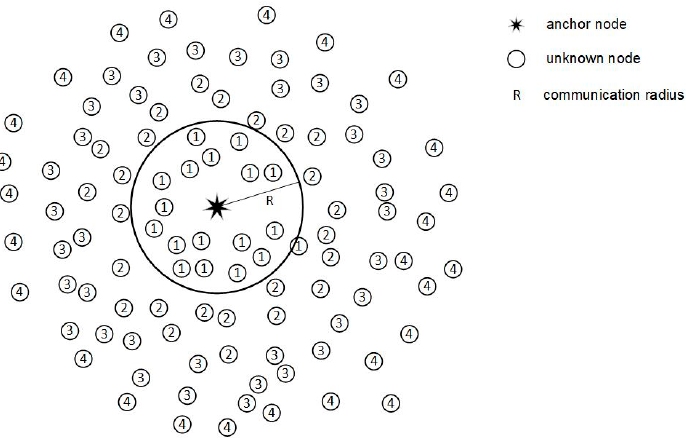
Figure 1. Propagation process of anchor node broadcast group. Phase 2: The actual distance between unknown nodes and anchor nodes is